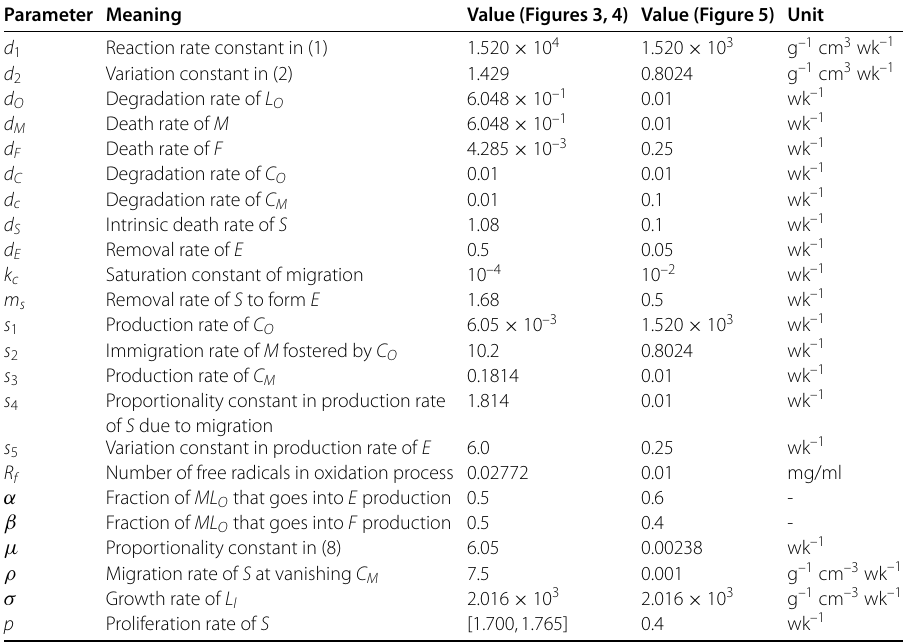
Table 2 Parametric values used in the model simulations shown in Figures 3-5 Parameter